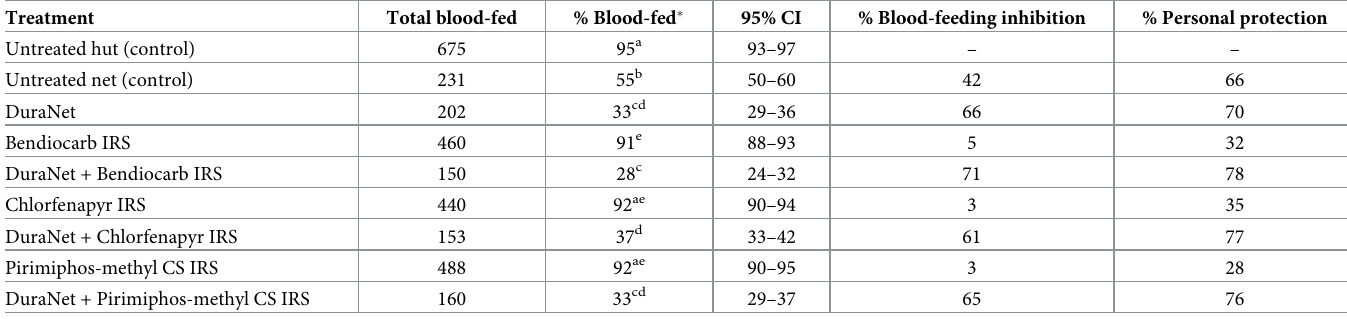
Table 4. Blood-feeding results of wild, pyrethroid-resistant Anopheles gambiae sensu lato entering experimental huts in Cov è , southern Benin. Treatment Total blood-fed % Blood-fed